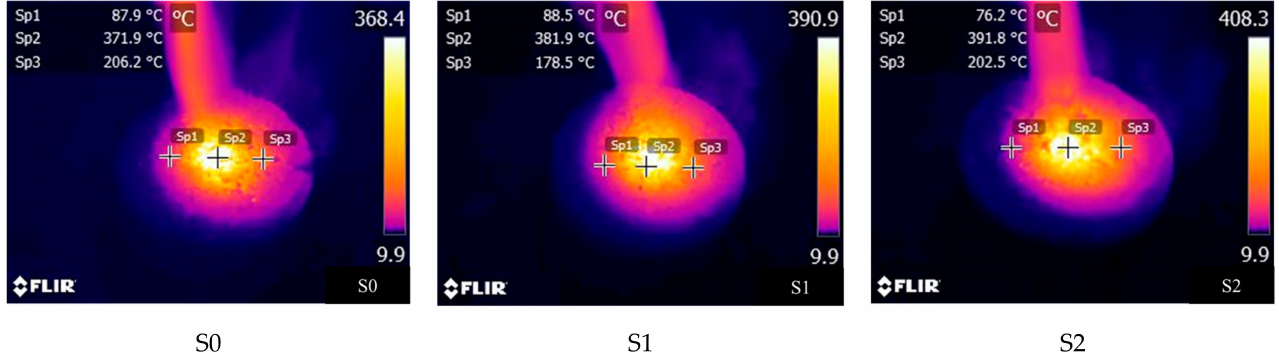
Figure 13. Infrared images of different samples during the ignition